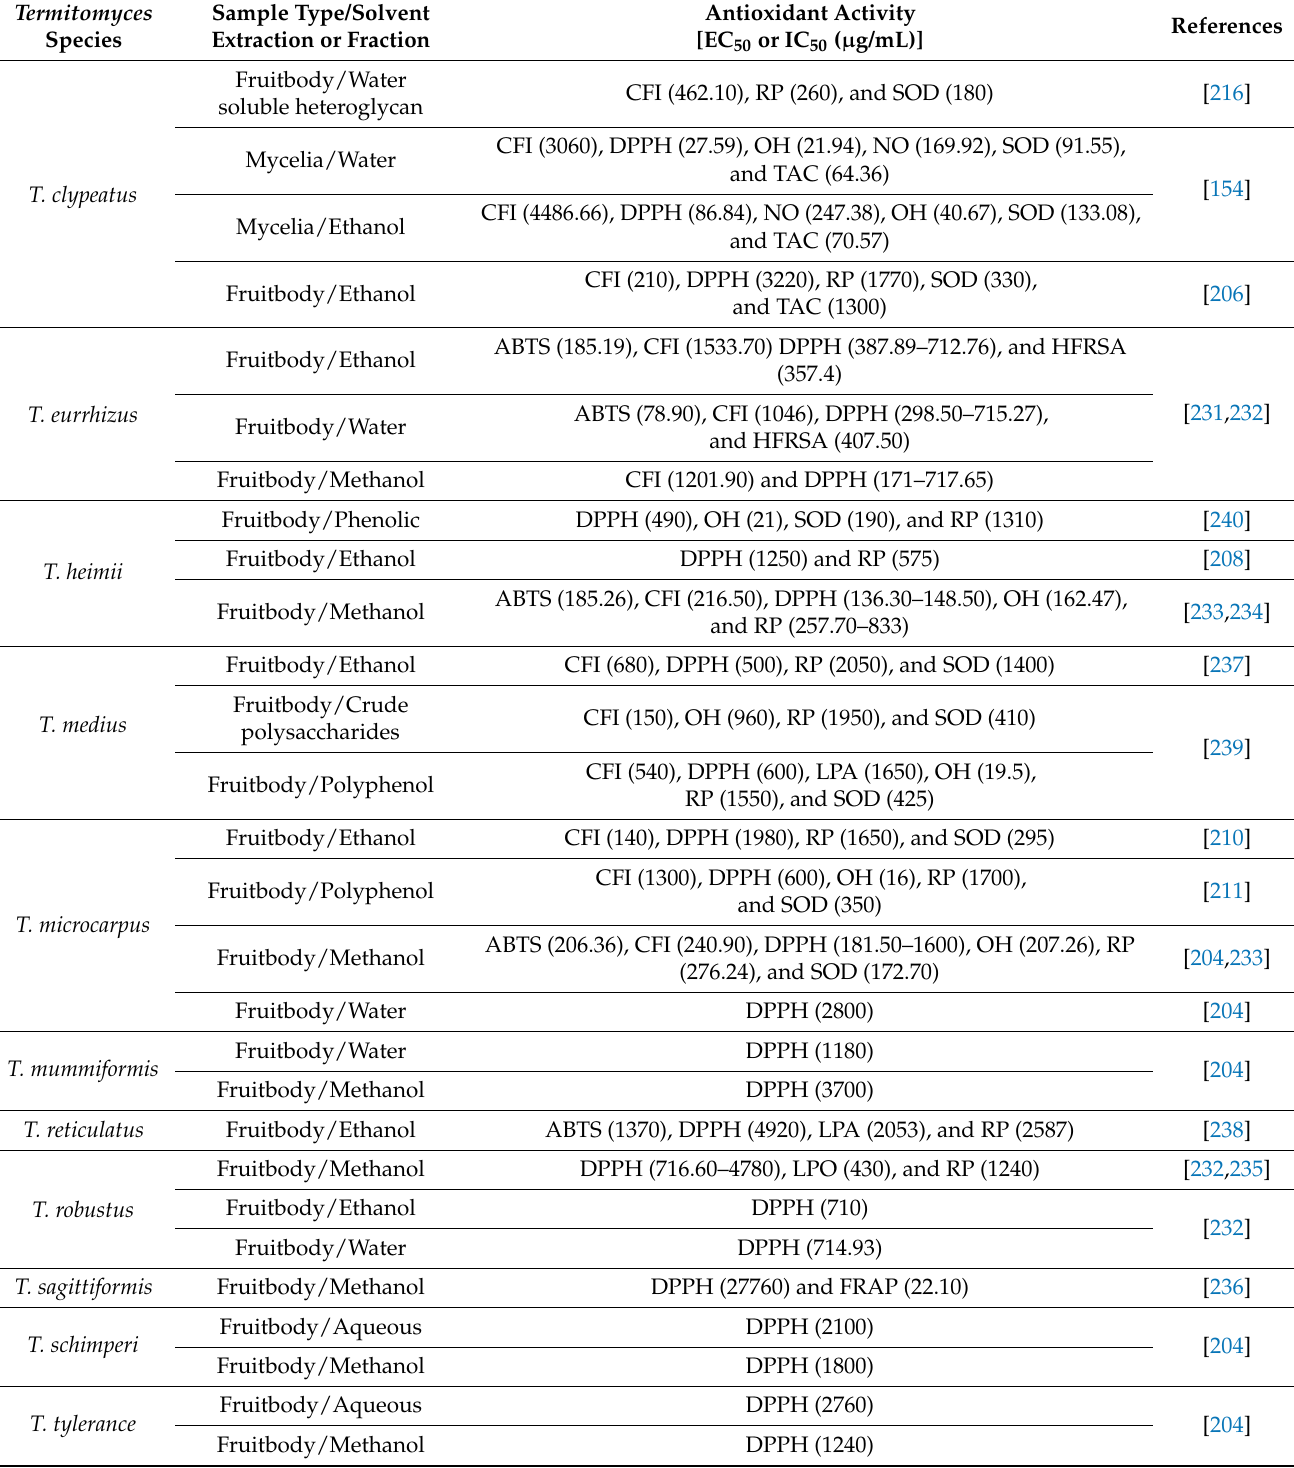
Table 6. In vitro antioxidant activity from different Termitomyces